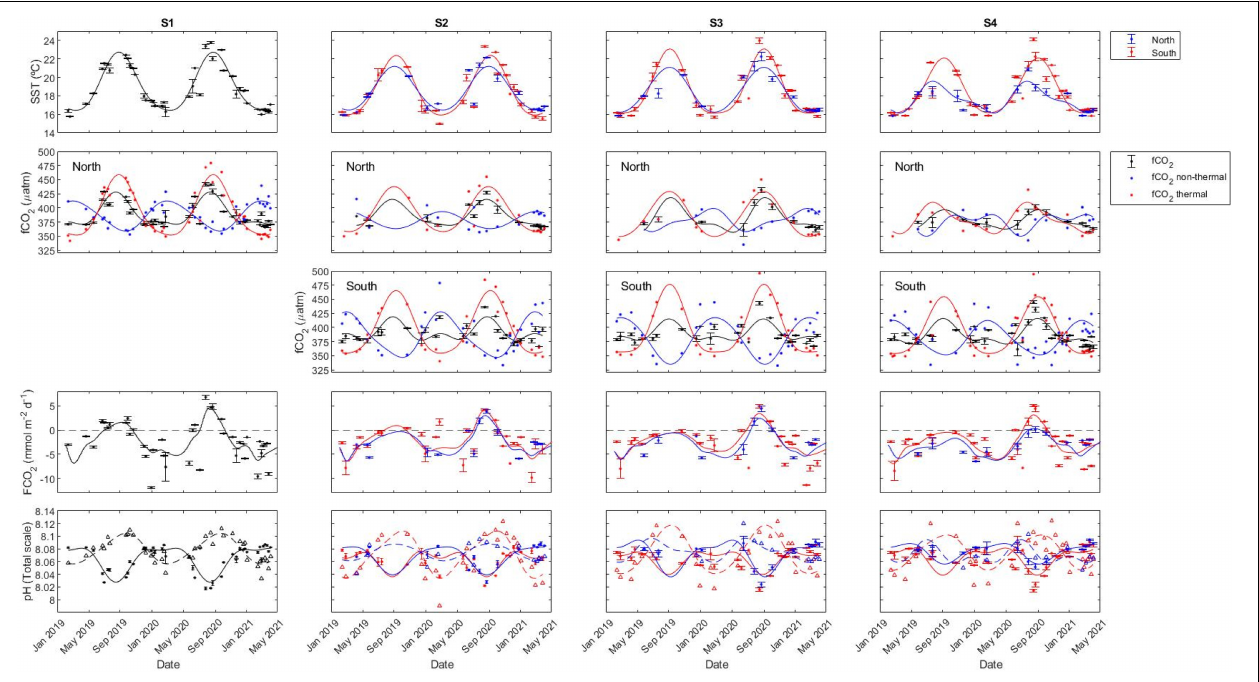
FIGURE 3 | Seasonal variability of average SST, f CO 2 , sw , f CO 2 , thermal , f CO 2 , non − thermal , FCO 2 , pH T , and pH T , 18 at the northern (blue) and southern (red) part of the station S1–S4 in the Strait of